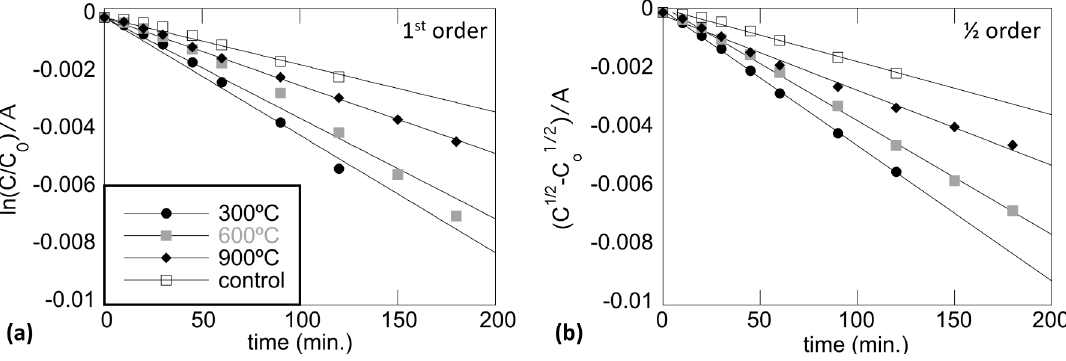
Figure 3. Concentrations of rhoB fit to the ( a ) first order and ( b ) half-order integrated rate law for varying annealing temperature (300–900 ◦ C). The best fit curves are indicated by the solid lines, with the slope of the best fit curves representing the photocatalytic activity. The control consists of degradation measurements made in the absence of catalyst films.